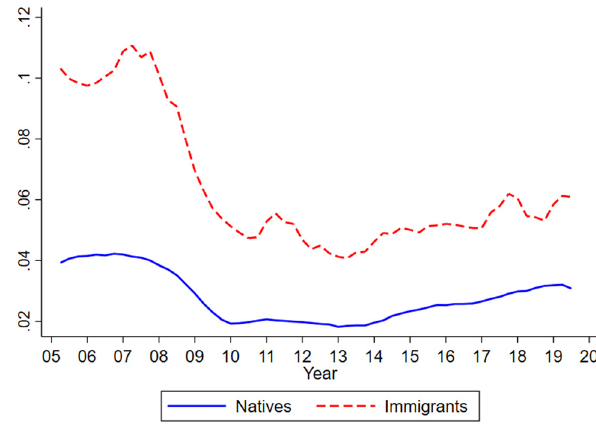
Figure A1: Job - to - Job transition rate, di ff erent employer. Notes: The transitions are seasonally adjusted using a 4 - quarters moving average, constructed from the Spanish Labour Force Survey